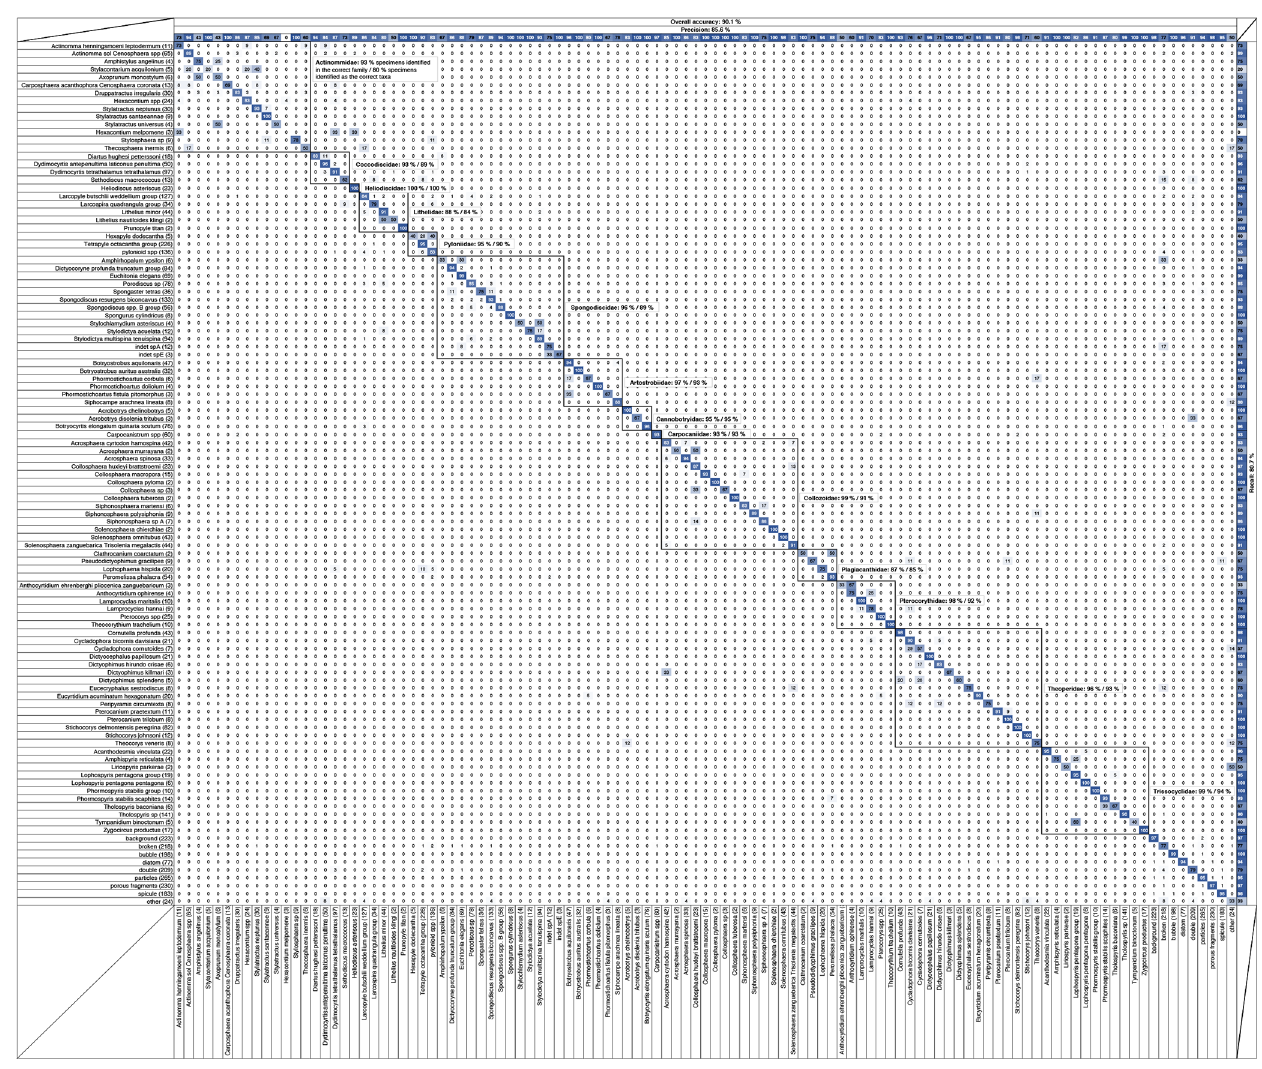
Figure 4. Confusion matrix showing the overall and individual accuracy, precision and recall for the 109 trained classes. Squared groupings correspond to radiolarian families. This figure is also available as a scrollable Excel spreadsheet in the Supplement (Table